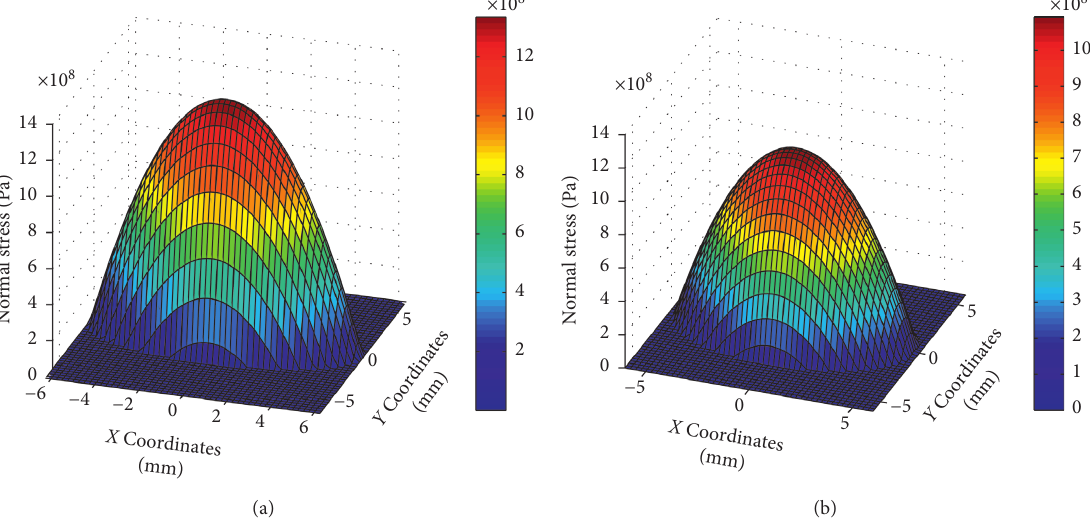
Figure 15: Distribution of the normal pressure: (a) before optimization and (b) after optimization.